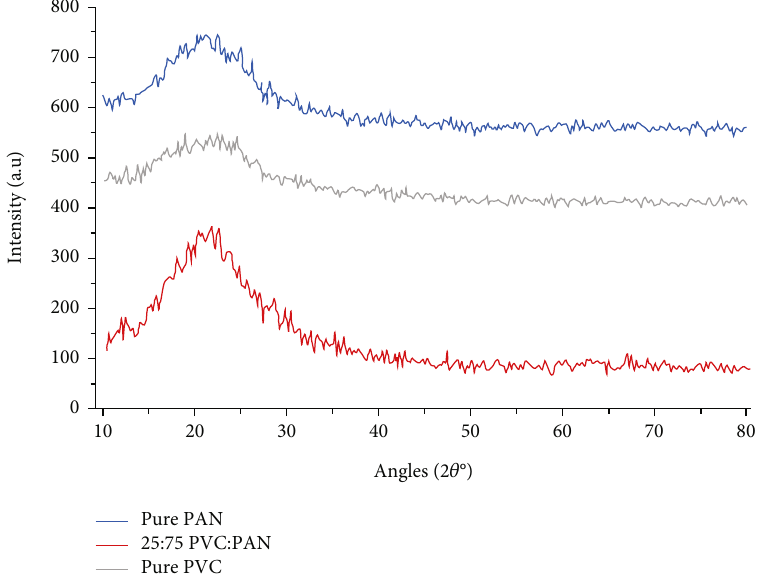
Figure 6: XRD spectra of pure PAN, pure PVC, and 25:75 PVC: PAN nano fi bers. Table 3: Results of XRD analysis of many calculated structural parameters such as crystallinity (%), crystalline size (nm), FWHM, re fl ection intensity, d-spacing (d), and peak position (2 θ ) of pure PAN, pure PVC, and 25 :75 PVC: PAN nano fi bers. Samples 2 θ d (nm) Rel. int. (%) FWHM Crystalline size (nm) Crystallinity (%) in (100) rel. int.